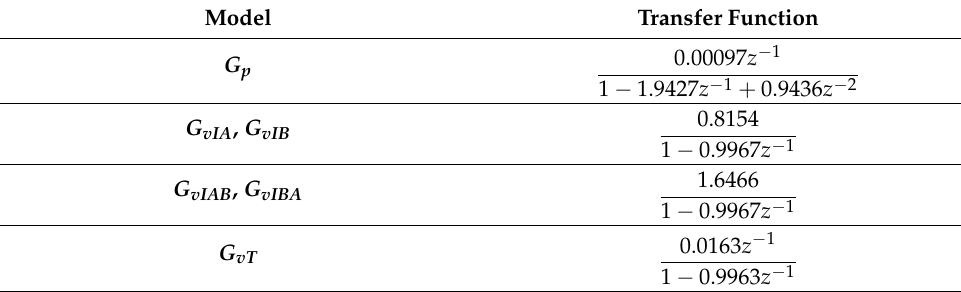
Table 10. Simplified dynamic models for OLMs and